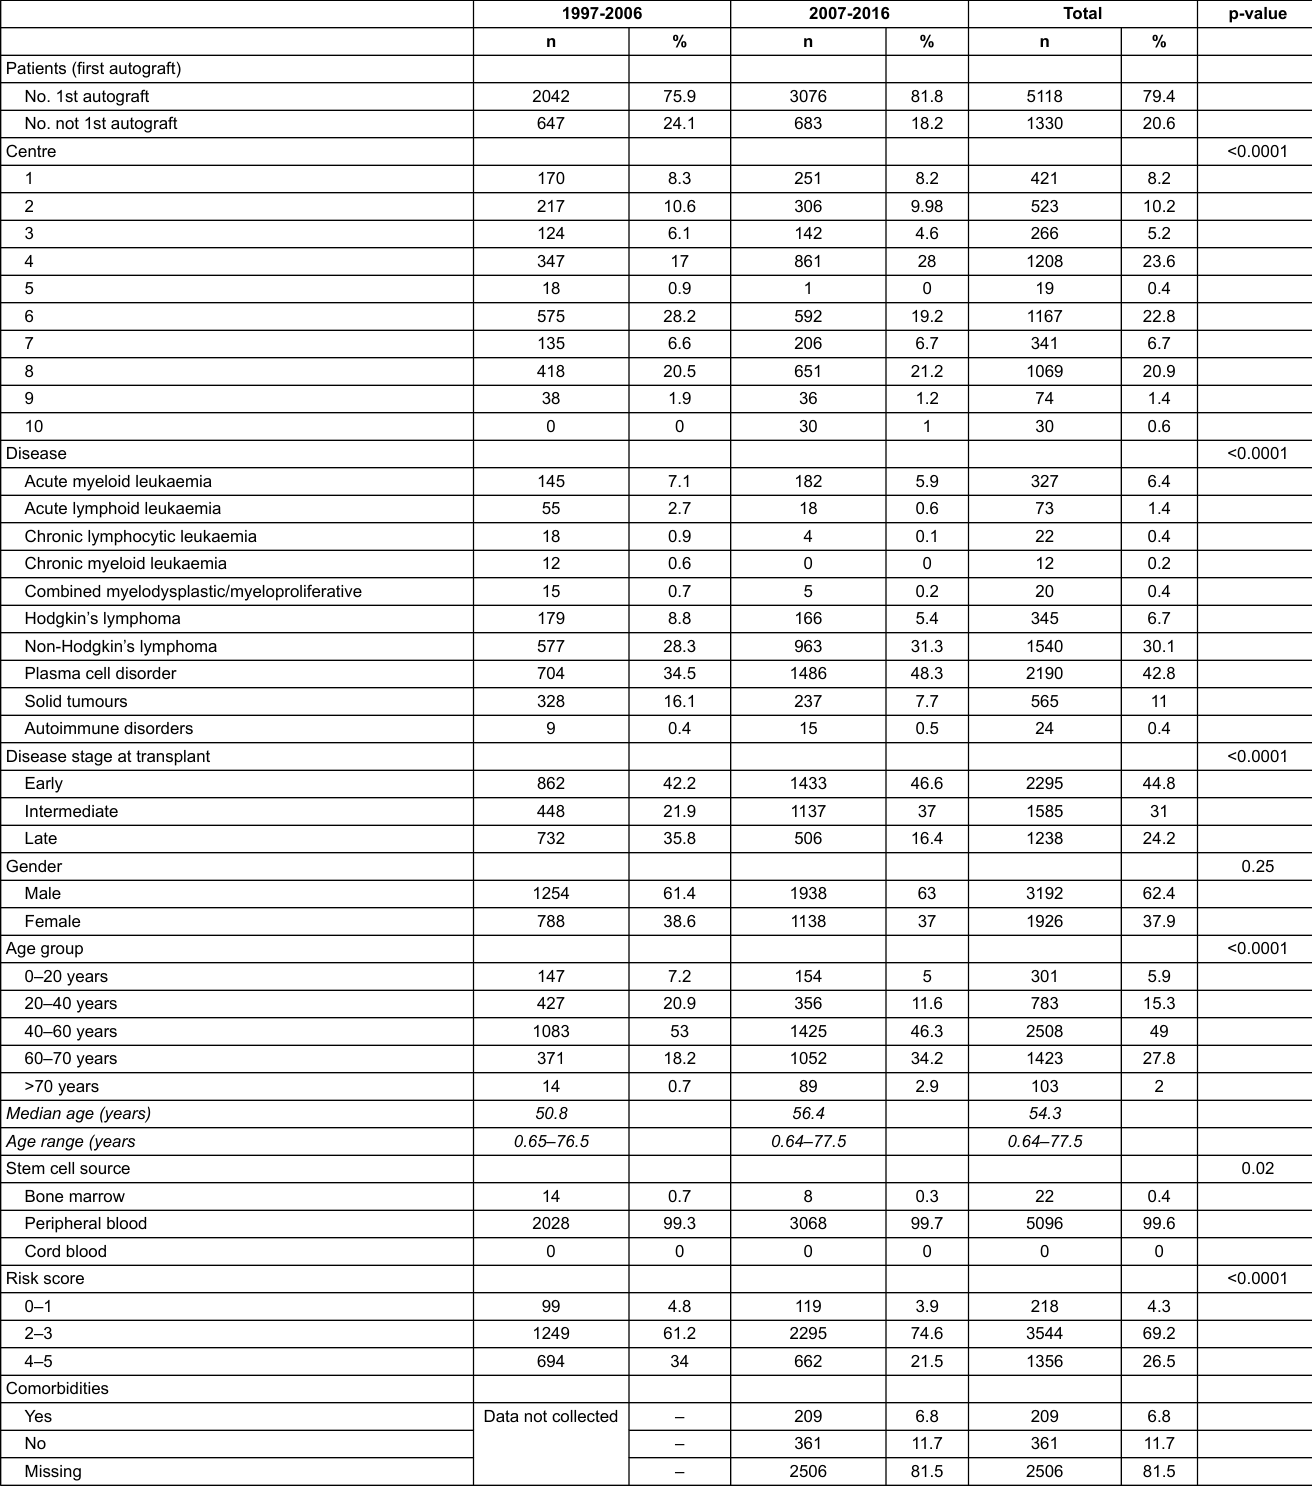
Table 1b: Demographic characteristics and transplant technology for autologous haematopoietic cell transplants by decade for the years